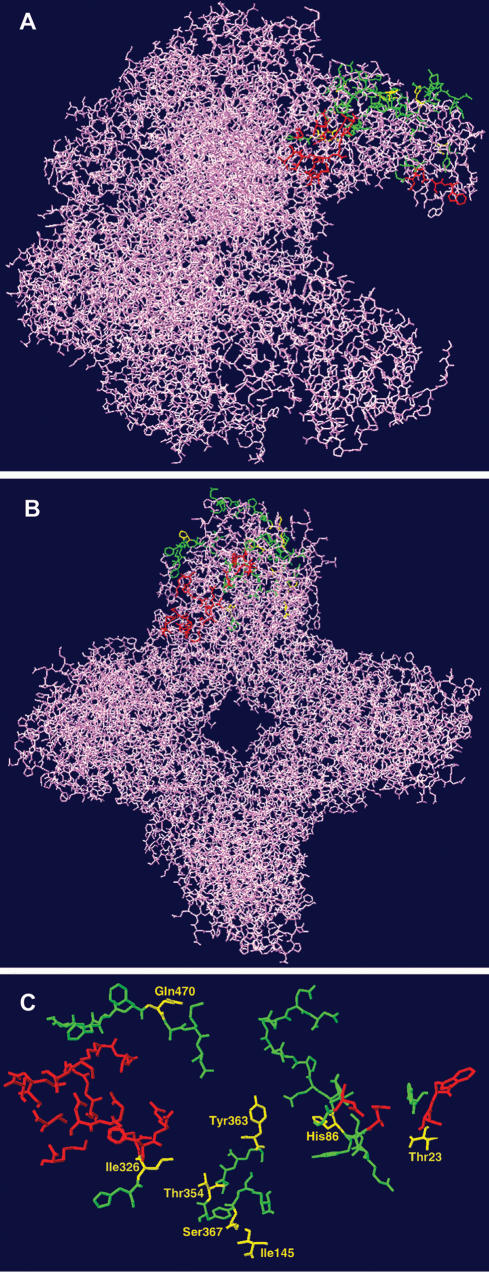
The structure of Rubisco enzyme in two projections (A, B) and (C) the residues that belong to active site (coloured red) and that are involved in interactions with Rubisco activase (coloured green; after [15], [24], [26], [27]).Eight residues replaced in Schiedea (positions 23, 86, 145, 326, 354, 363, 367, 470) are coloured yellow.